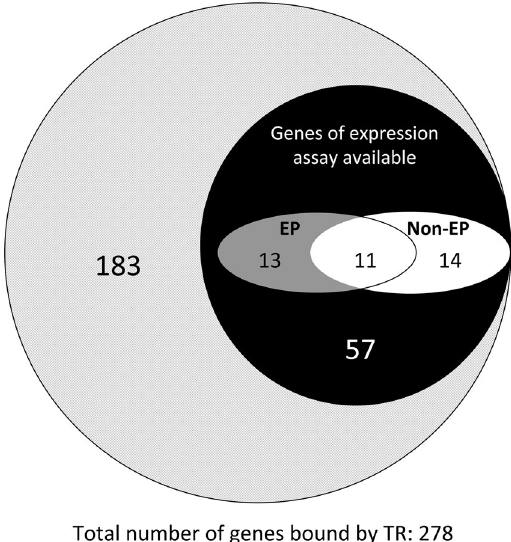
Figure 6. Venn diagram showing overlap of the TR target genes identified by ChIP-on-chip assay with known developmentally regulated genes identified from an early expression microarray study. Of the 278 TR target genes identified by ChIP-on-chip assay, 95 or 34% were also found on the microarray used for the expression study (Note that the actually overlap might be higher as most genes may have different names on the microarray chips used in the expression study and on the genomic chips used here, therefore showing up as non- overlapping). Of the 95 genes present in the gene expression microarray, 38 were found to be regulated during metamorphosis in the intestine in either the epithelium (EP, 13 genes), non-epithelium (Non-EP, 14 genes) or both (11 genes), suggesting that about 40% of the genes identified here are regulated by T3 during intestinal